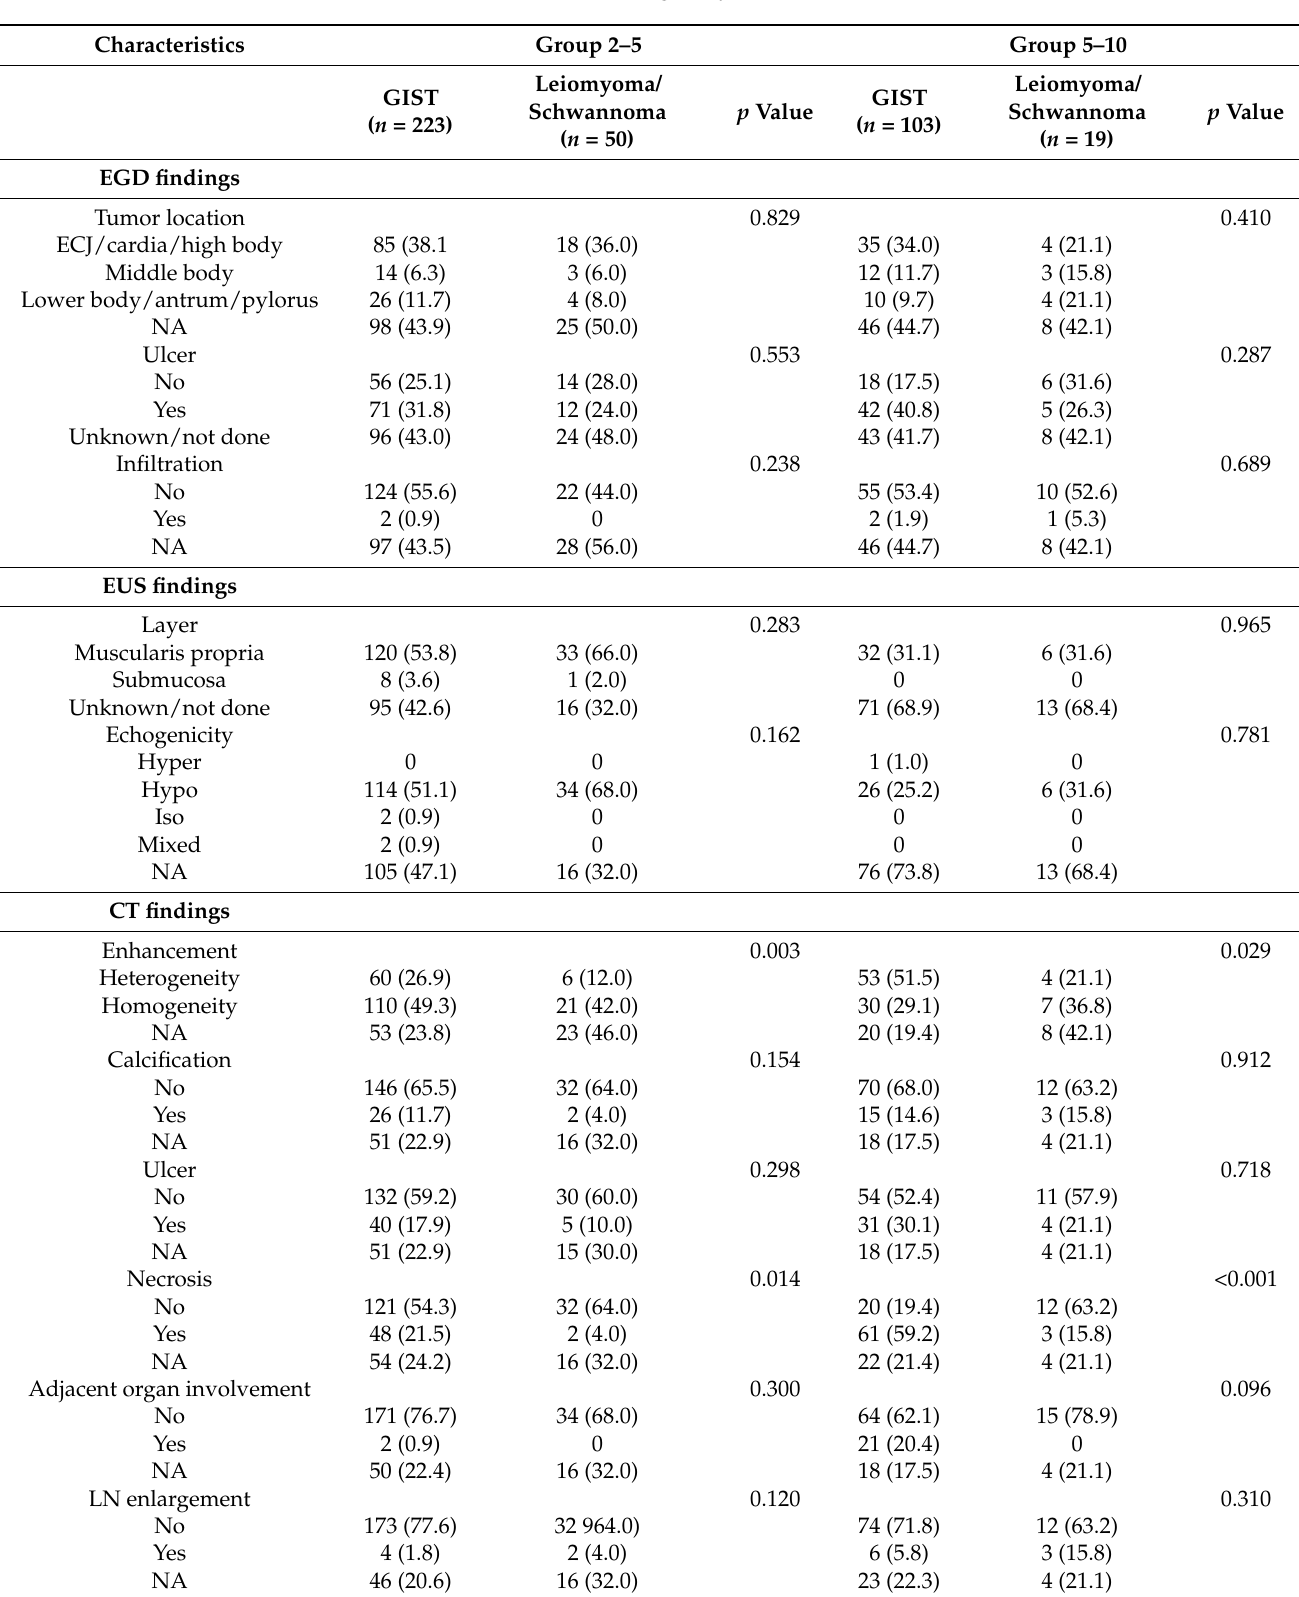
Table 2. EGD, EUS, and CT finding